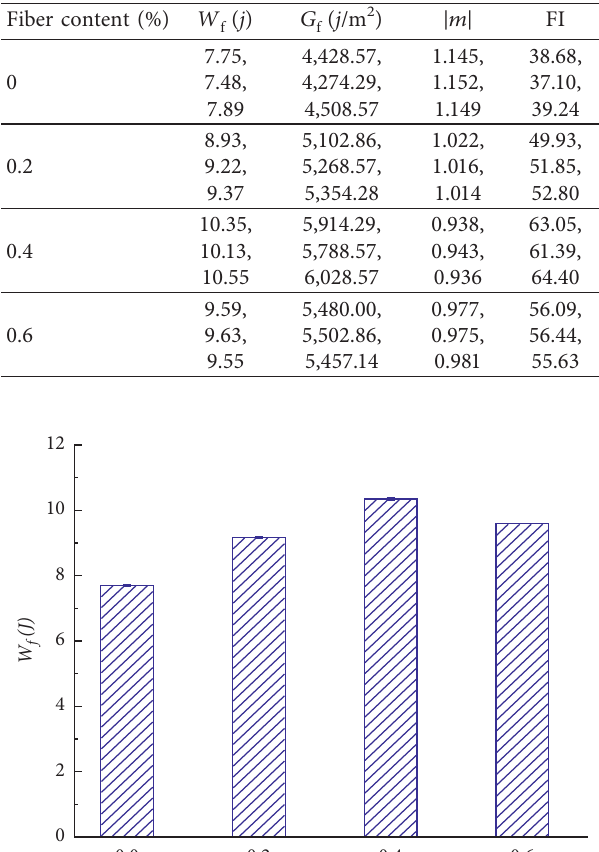
Table 10: Semicircular bending test results of microbond asphalt macadam with different fiber contents.